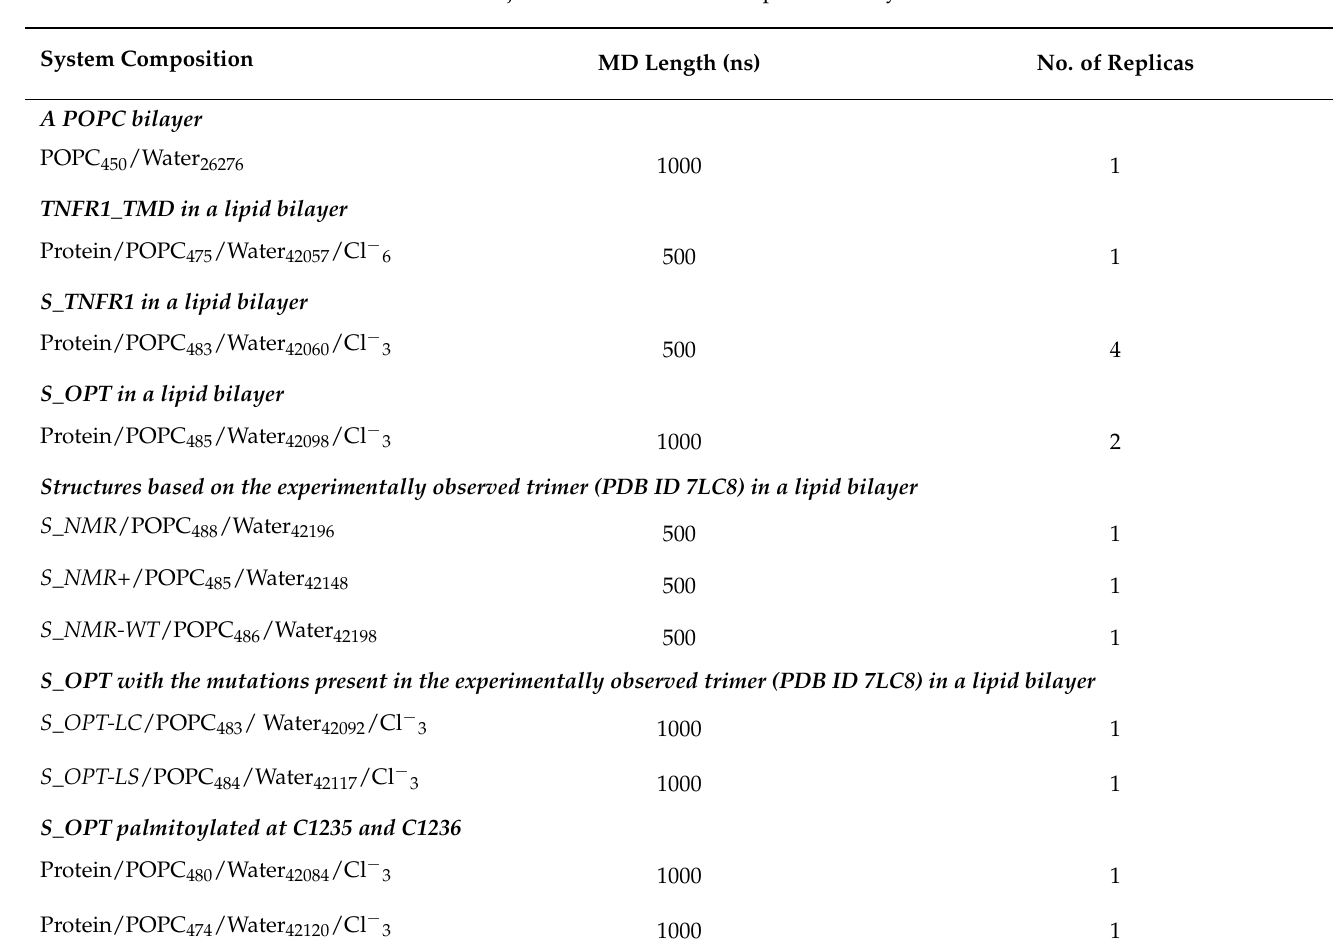
Table 2. MD trajectories calculated in the present